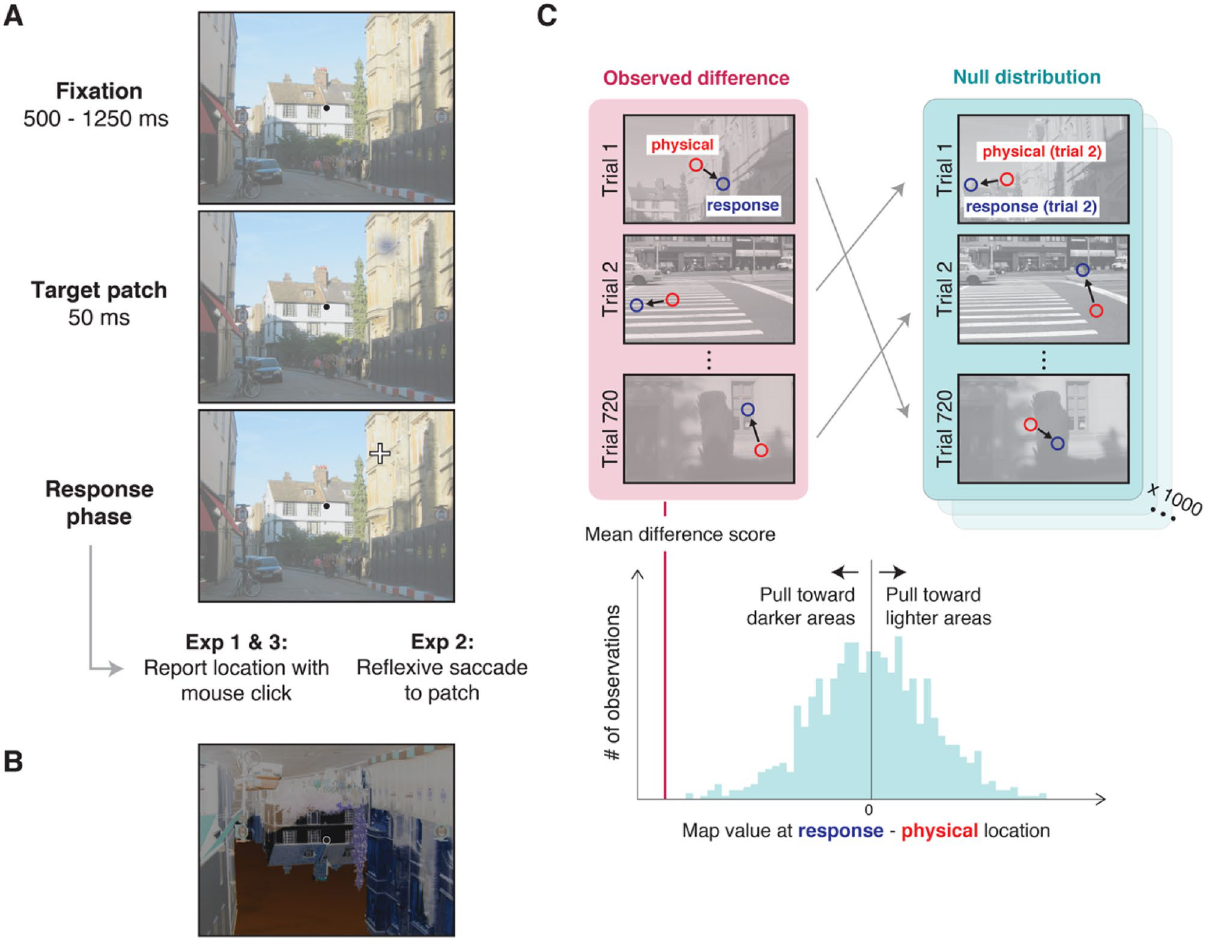
Figure 1. ( A ) On each trial, observers continuously fixated a dot at the center of the display for a random interval between 500 and 1250 ms. A brief (50 ms) Gaussian target patch was randomly presented at one of 72 possible peripheral locations (3 eccentricities × 24 angular locations; shown here in the upper-right portion of the image). Observers then either reported its location by moving a crosshair controlled by a mouse while maintaining fixation (Experiments 1 and 3), or made a reflexive saccade to the target (Experiment 2). ( B ) The images used in Experiment 3 were color negatives of the original image, and flipped upside down. ( C ) To measure the influence of different image features on localization errors, we calculated difference scores from the image value at the physical center of the patch location (“physical”; red) and the location reported by the observer (“response”; blue, hypothetical example shown with luminance maps). In the example, negative values indicate that responses are pulled toward darker areas in the image, and positive values indicate that responses are pulled toward lighter areas. To isolate image-specific effects from other potential reporting biases, the observed mean difference score was compared to values in a null distribution, which was calculated by randomly shuffling the physical and response coordinates in relation to other images. In the example, the images in the right column are in the same order as the original trials, but the coordinates are taken from different trials (randomly shuffled on each iteration), indicated by the gray arrows. For example, the coordinates from trial 2 were used to calculate a difference score for the image in trial 1. A mean difference score was calculated from all shuffled trials, and this procedure was repeated for 1000 iterations to produce a null distribution of difference